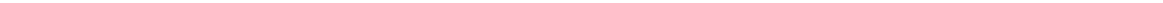
Fig. 3 Serpine1:miR-30b/c interaction controls miR-30b/c degradation. a Percentage contribution and copies-per-cell for each member of the miR-30 family in growing cells are shown, based on absolute quanti fi cation data in Supplementary Fig. 3a – c. b Absolute quanti fi cation of miR-30c-5p and Serpine1 in 3T9 model. Data refer to three independent biological experiments (average and s.e.m). c A target-per-miRNA (TPM) value was calculated based on absolute quanti fi cation. d Strategy for the CRISPR-Cas9-mediated removal of miR-30 MRE from Serpine1 3 ′ UTR. Shown are the positions of the sgRNAs